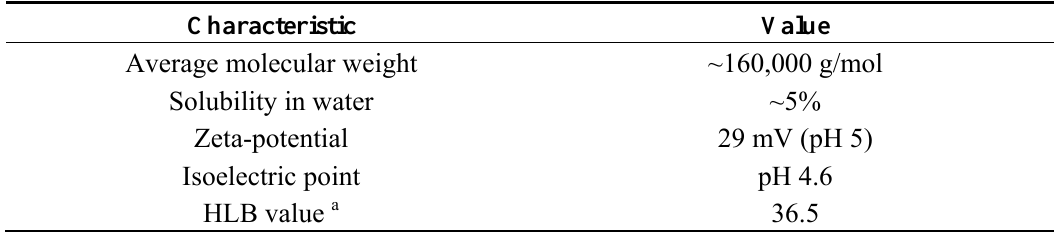
Table 1. Some important characteristics of Chitosonic ®